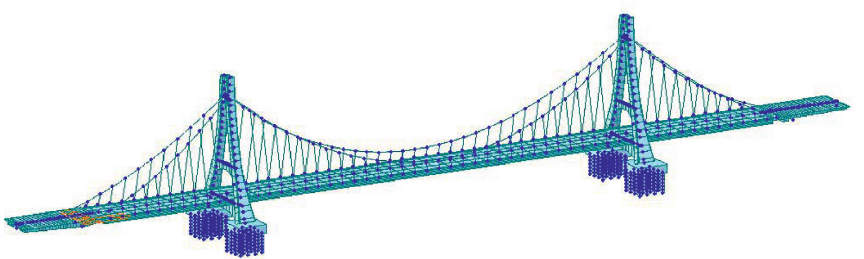
Figure 6: Finite element model of bridge